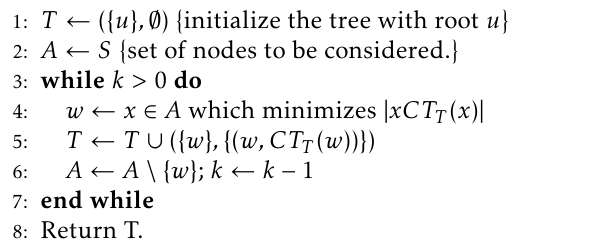
Algorithm 4 k-Prim( u; S; k ) – Return a k -MST of S ∪ { u } rooted in u .